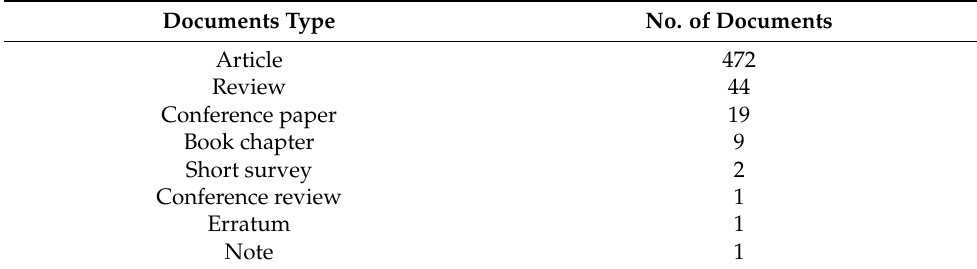
Table 1. The analysis of the search results is shown in Figure